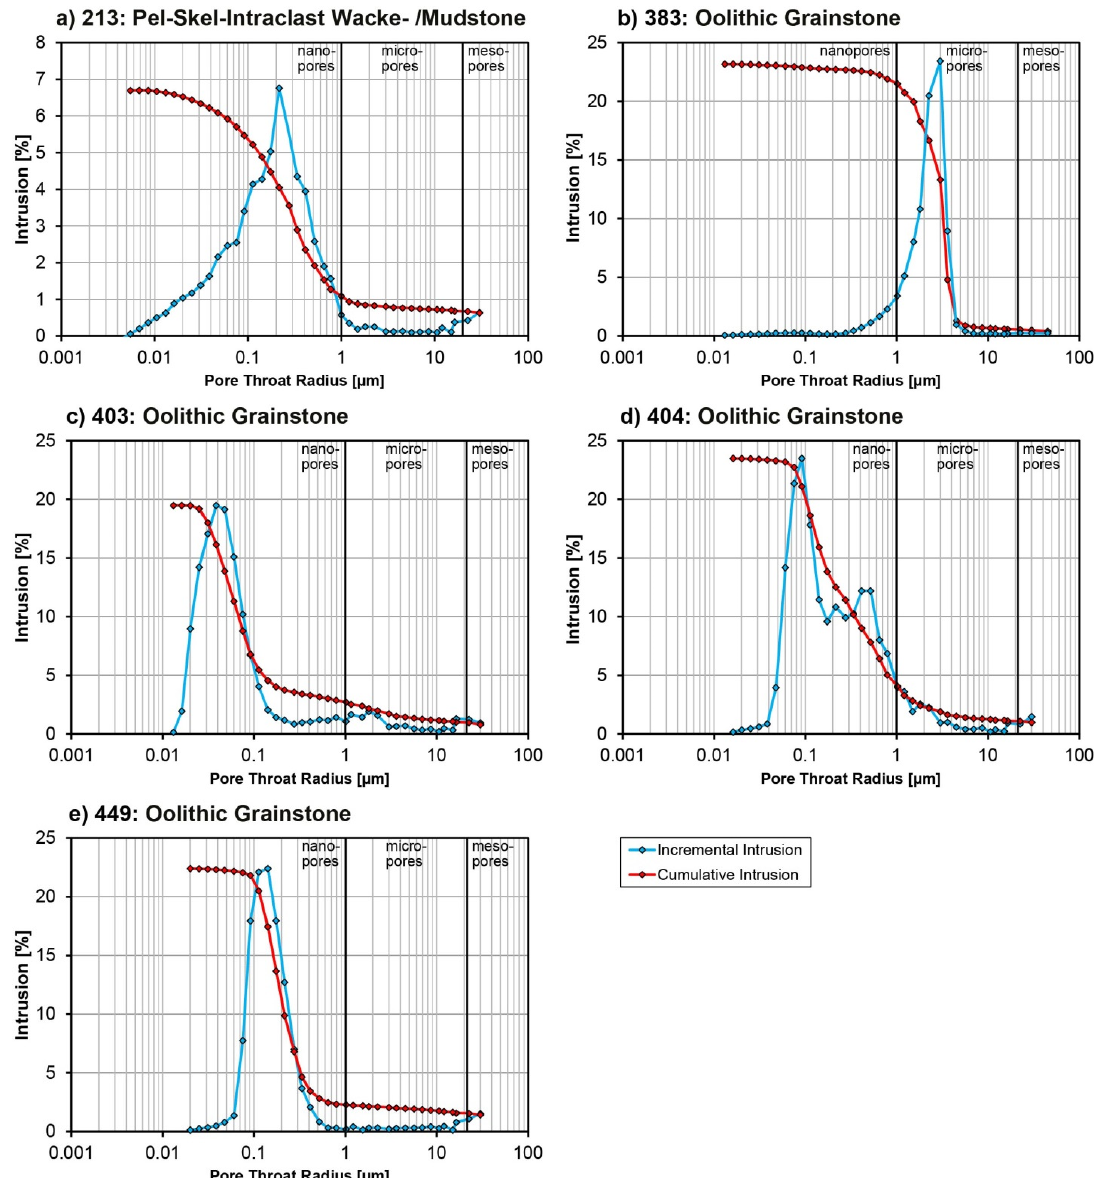
Figure 8. Incremental and cumulative mercury intrusion versus pore-throat size-distribution of samples 213 ( a ), 383 ( b ), 403 ( c ), 404 ( d ) and 449 ( e ) based on MICP analysis. The y -axis accounts for both incremental as well as cumulative intrusion as both are normalized to their highest respective intrusions.